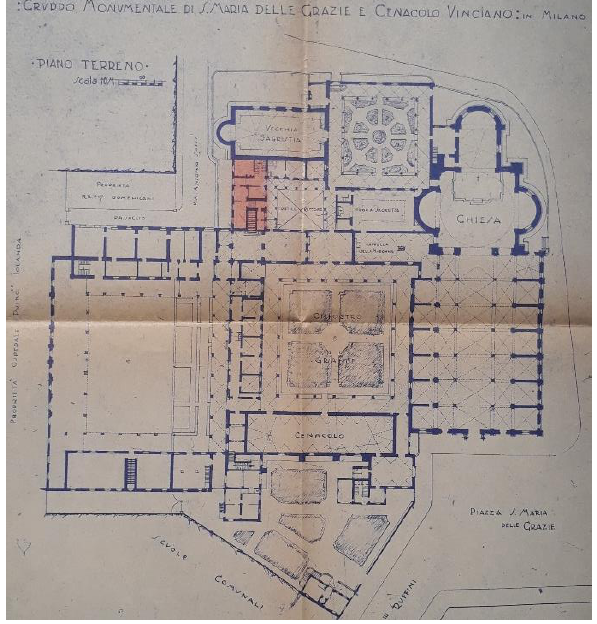
Figure 1. Plan of the convent before the II World War. This cloister, more than any other parts of the convent, was object of non-accidental demolitions and reconstructions in the attempt to use via Sassi as privileged monumental access to the church, facing the Bramante’s tribune (AAVV, 2003).